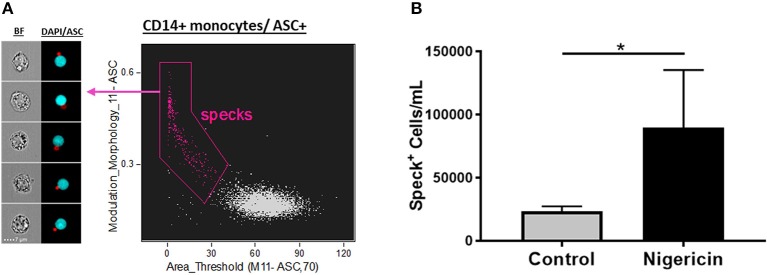
Quantification of ASC specks in nigericin stimulated-CD14+ monocytes. (A) Dot-plot of Area_Threshould(M11,11-ASC70) vs. Modulation_Morphology(M11,Ch11)_11-ASC inside CD14+ monocyte gate better identifies ASC specks in pam3csk4 (0.5 ug/mL, 3 h)- primed and nigericin (3.5 uM, 1 h)-stimulated PBMCs. On the left side of the graph, representative images of Speck+CD14+ monocytes were selected, showing, respectively: BF (brightfield) and composite image of the two fluorescences (ASC and DAPI). Intensity fluorescence was augmented for the purpose of imagery, not affecting results and statistics. (B) Quantification of Speck+ monocytes/mL in control vs. Nigericin-stimulated cultures after Area_Threshould(M11,11-ASC70) vs. Modulation_Morphology(M11,Ch11)_11-ASC dot-plot was applied in all data set. Numbers are the means ± SEM (n = 5). *P < 0.05 when Mann-Whitney test was applied.